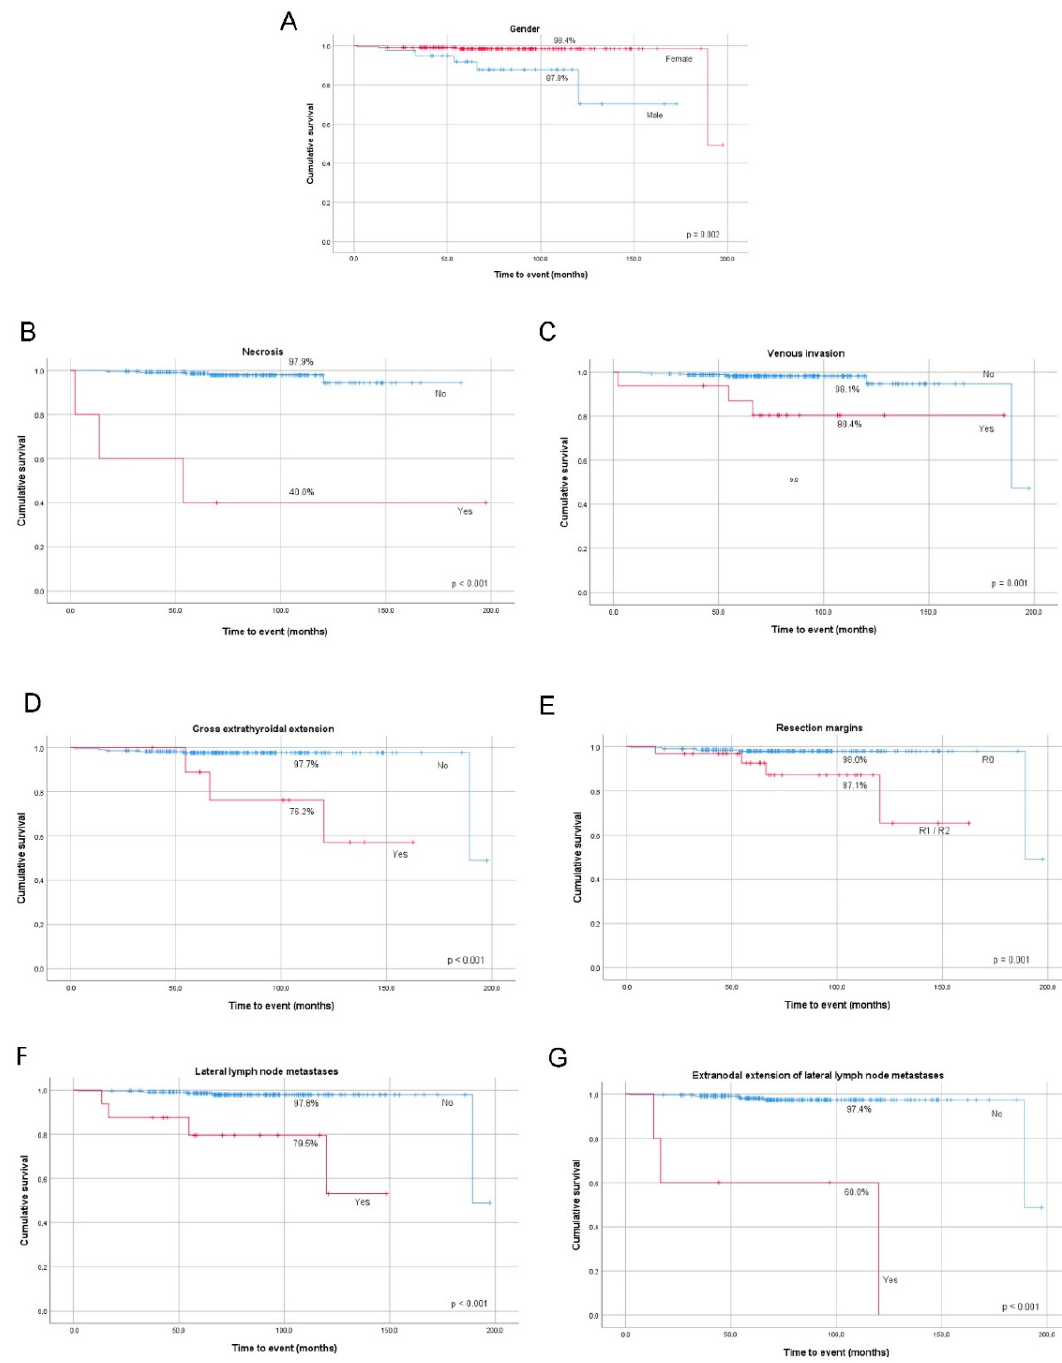
Figure 3. Kaplan–Meier survival curves of PTC disease-specific survival (DSS) by gender ( A ), presence of necrosis ( B ), venous invasion ( C ), gross extrathyroidal extension ( D ) resection margins status ( E ), metastases to lateral lymph nodes ( F ), and extranodal extension of lateral lymph node metastases ( G ).